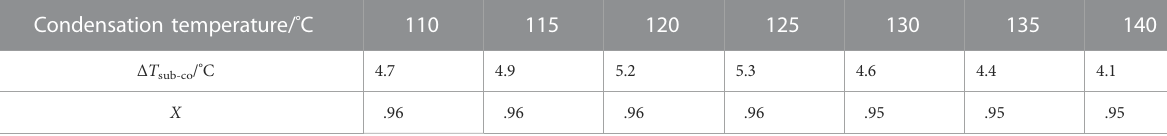
TABLE 2 x and Δ T sub-co change trend with condensation temperature.